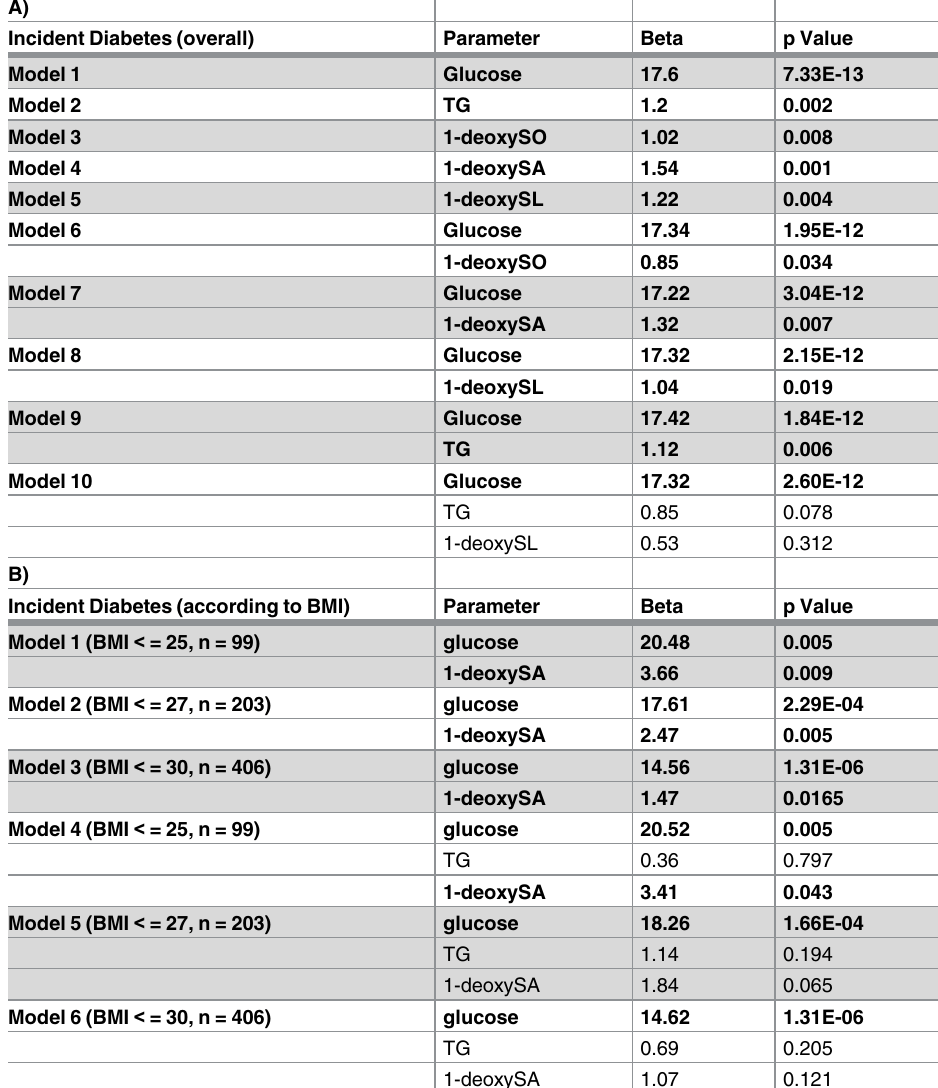
Table 3. Binary logistic regression models for incident T2DM (n = 605).